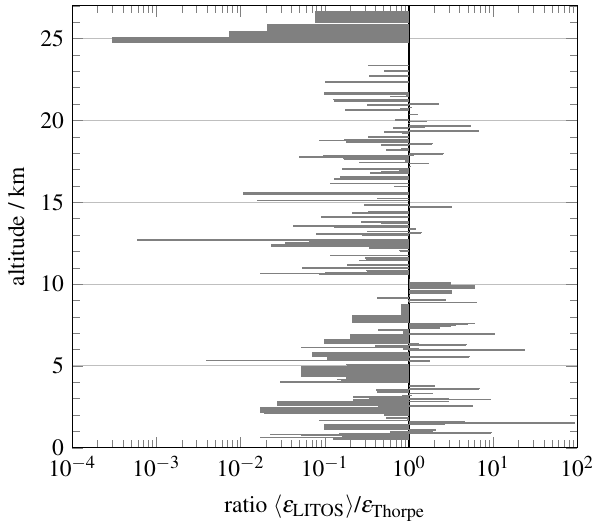
Figure 8. Ratio between energy dissipation rates from spectral anal- ysis and from Thorpe analysis for the significant, unstable layers of the BEXUS 12